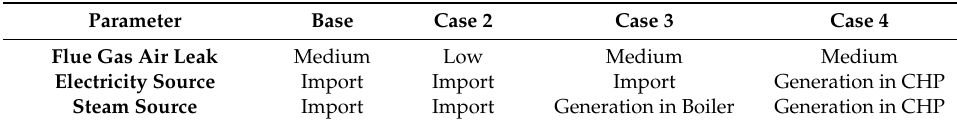
Table 4. Definitions and parameters.